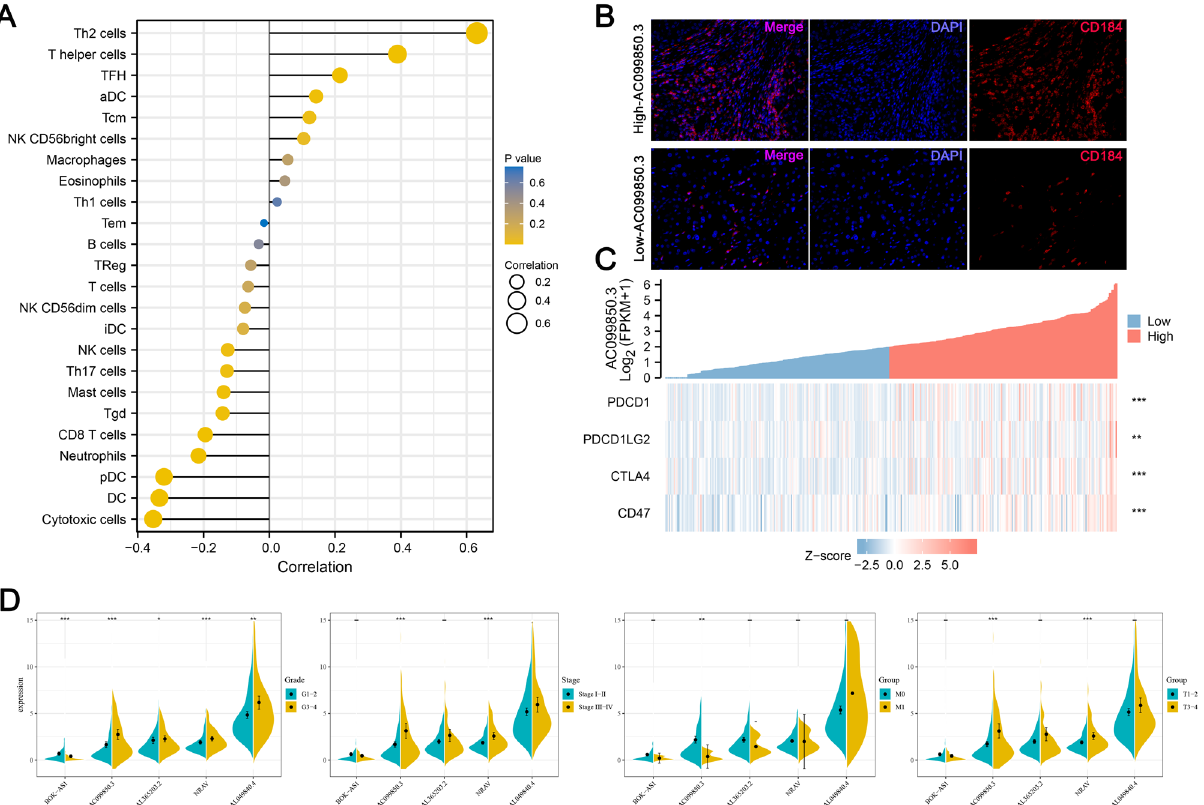
Figure 5. Clinical value of AC099850.3 and its association with immune features for HCC patients. (A) Lollipop-diagram showing that AC099850.3 was strongly correlated with immune cells, including Th2 cells and T helper cells. (B) Representative immunofluorescence images indicated different CD184 levels in high and low AC099850.3 expressing tissues. (C) Heatmap showing positive association between AC099850.3 expressions and several immune checkpoints. (D) Violin plot demonstrating that AC099850.3 was strongly associated with HCC progression, including Grade, Stage, T stage and M stage, compared to other prognostic costimulatory molecule-related lncRNAs. FPKM Fragments Per Kilobase of exon model per Million mapped